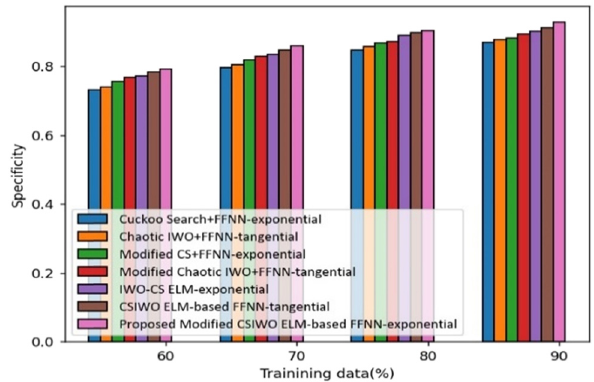
Figure 5: Analysis based on the linear value function - based